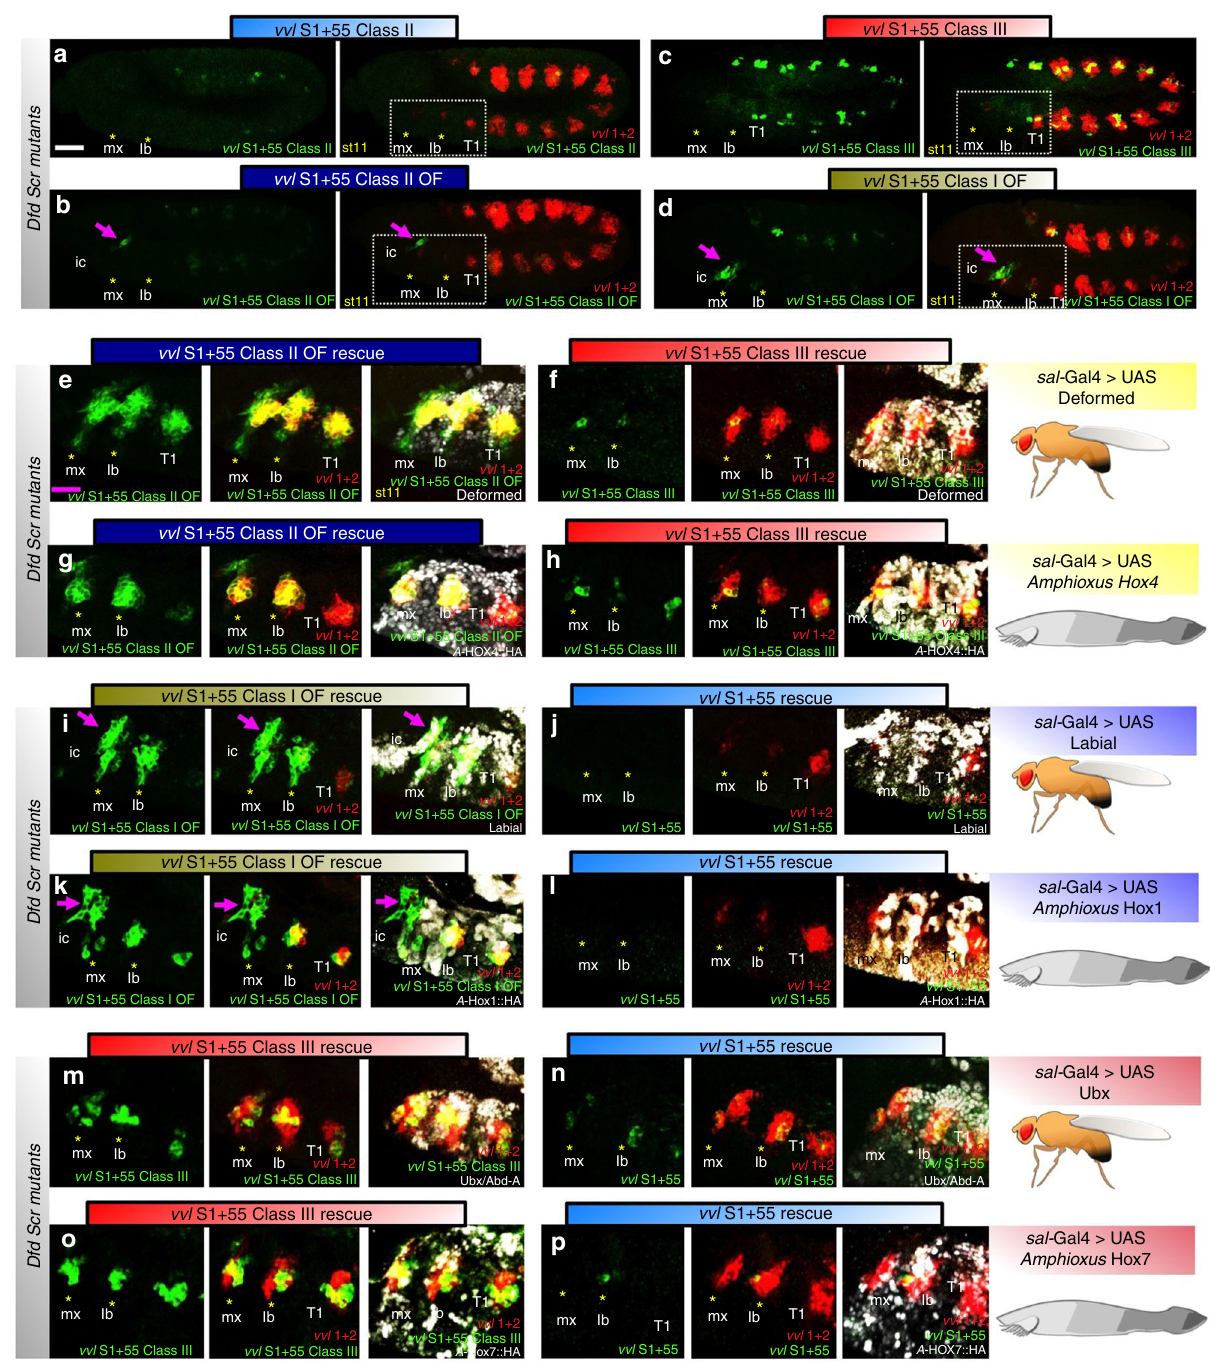
Fig. 4 Sequence speci fi c activation of Hox target genes by Drosophila and Amphioxus Hox proteins. Expression in Dfd Scr mutants of S1 + 55 class 2 ( a ), S1 + 55cl2OF ( b ), S1 + 55cl3 ( c ), S1 + 55cl1OF ( d ) is lost in the maxillary (mx) and labial (lb) segments (asterisks). Purple arrow points to intercalary segment expression. Rectangles in (a-d, right panels) highlight the intercalary (ic), maxillary (mx), labial (lb) and fi rst thoracic segment (T1). No expression is observed in the mx or lb segments of vvl1 + 2 (red) or any of the variants (asterisks), arrow points to ic segment expression. e – p Close-up of the ic, mx and lb segments of Dfd Scr embryos where a Drosophila or its Amphioxus orthologous Hox proteins are expressed to test their capacity to activate different S1 + 55 variants. e Dfd can rescue S1 + 55cl2OF and vvl1 + 2 but cannot activate S1 + 55cl3 ( f ). g AHox4 can activate S1 + 55cl2OF but cannot activate S1 + 55cl3 ( h ). i Lab can activate S1 + 55cl1OF but cannot activate S1 + 55 containing a class 2 site ( j ). k AHox1 can activate S1 + 55cl1OF but cannot activate the S1 + 55 containing a class 2site ( l ). m Ubx can rescue S1 + 55cl3 but cannot activate S1 + 55 containing a class 2 site ( n ). o Al-Hox7 can activate of S1 + 55cl3 but cannot activate an S1 + 55 class 2 containing site ( p ). White scale bar 50 μ m, purple scale bar 25 μ